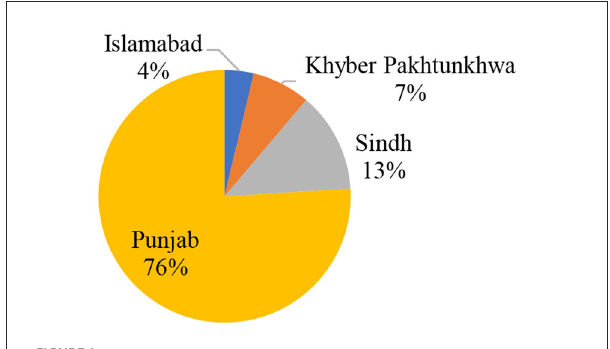
FIGURE1 Number of PAC clients reported from the